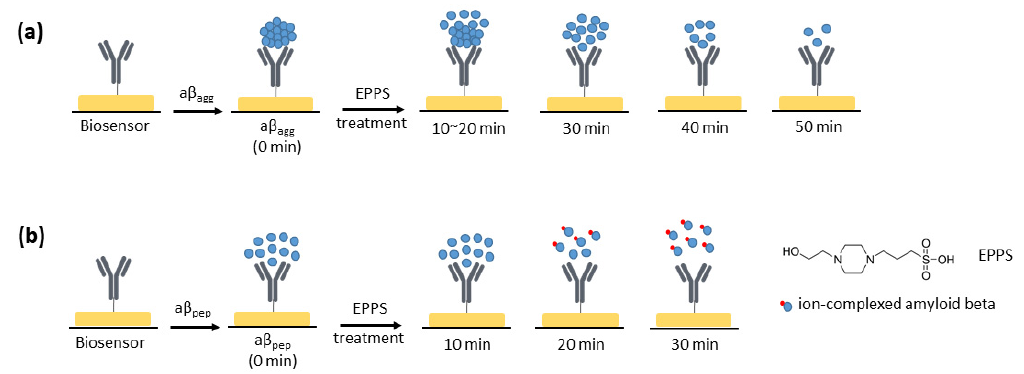
Figure 7. EIS results monitoring the disaggregation a β agg with the treatment in EPPS at different time intervals display in ( a ) Nyquist plots and ( b ) Normalization of R ct . (n = 3; three data points shown).